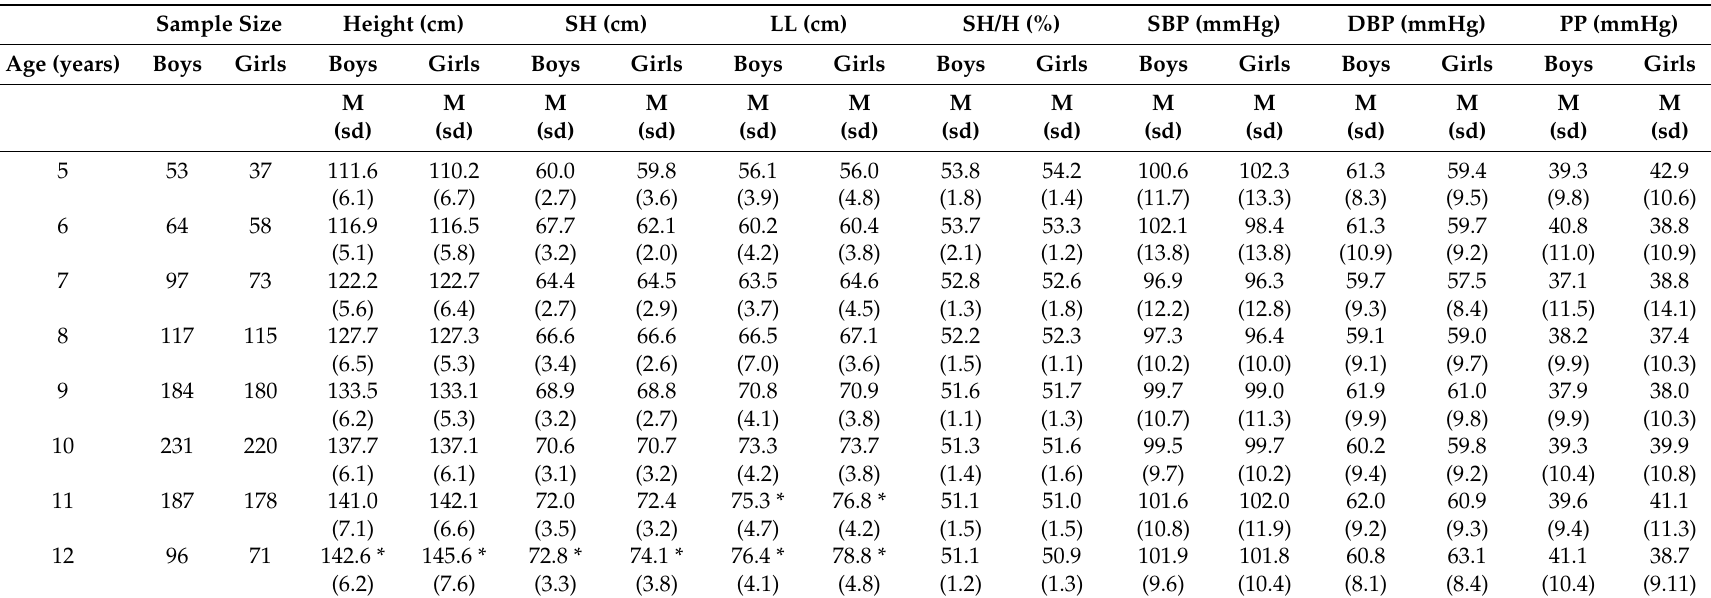
Table 1. Descriptive statistics of components of height and blood pressure parameters of Ellisras children aged 5–12